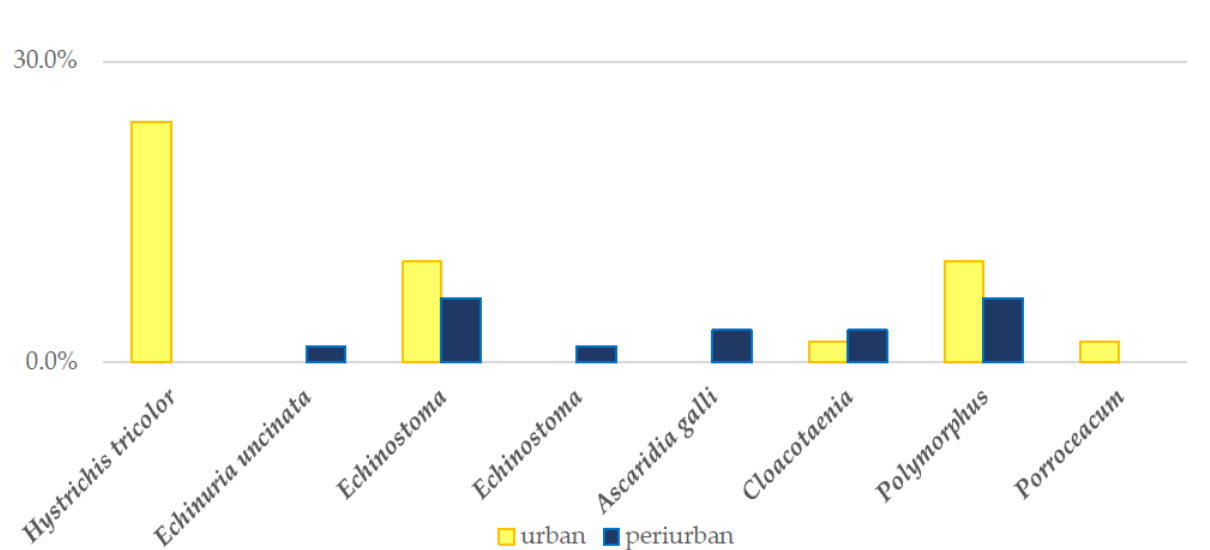
Figure 3. Adult metazoan endoparasite species detected in Egyptian geese ( Alopochen aegyptiaca ) in carcasses from urban and peri-urban habitats. This figure represents both an extract of the composition of parasite species and their abundance (urban Egyptian geese were infected with five different species of endoparasites and eleven different species were identified in rural animals) in urban and peri-urban areas.